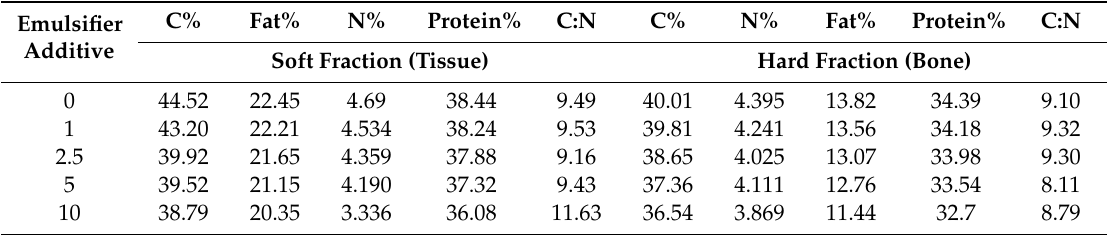
Table 1. Properties of the biogas process feedstock in individual research objects [%].